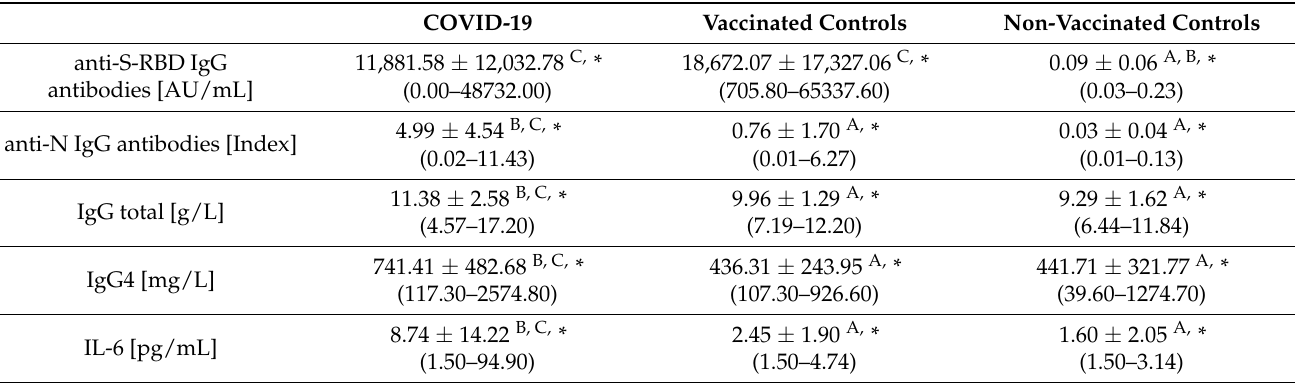
Table 2. The results of specific anti-SARS-CoV-2 antibodies, IgG total and IgG4 in tested groups. Variable tested. Mean ± SD (min–max values).